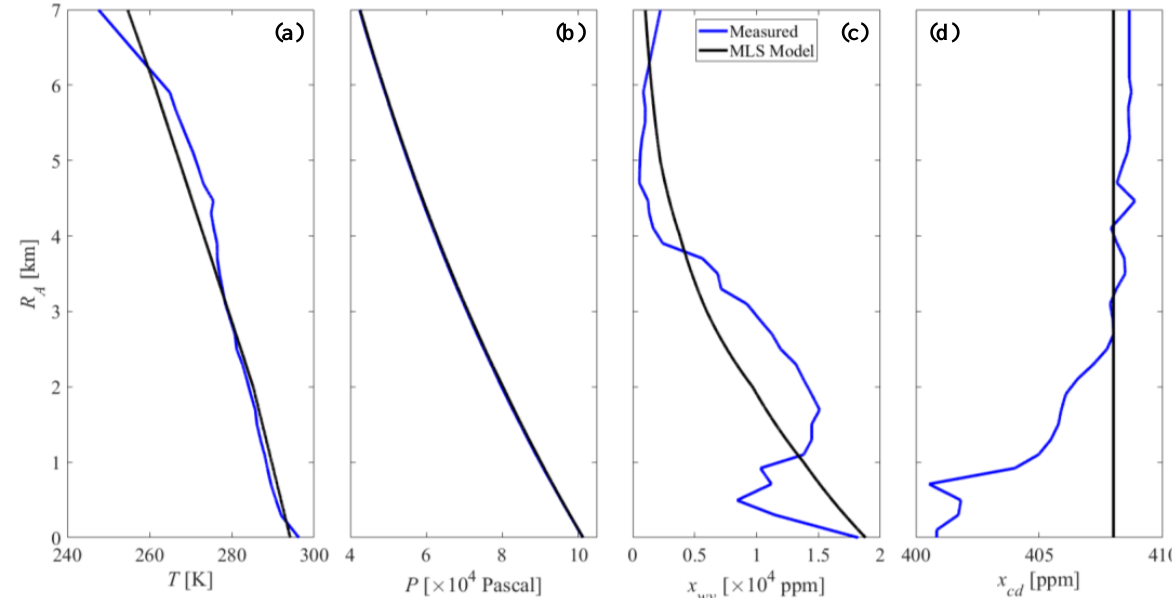
Figure 8. Vertical profiles of ( a ) temperature, ( b ) pressure, and dry-air mixing ratios of ( c ) water vapor and ( d ) carbon dioxide during IPDA lidar airborne testing onboard NASA B-200 aircraft conducted on 17 September 2019. Processing included 200-m range-bin averaging and 1-m linear interpolation for the data presented in Figure 6. The profiles are compared to MLS atmospheric model, except for carbon dioxide, which is assumed constant at 408 ppm.